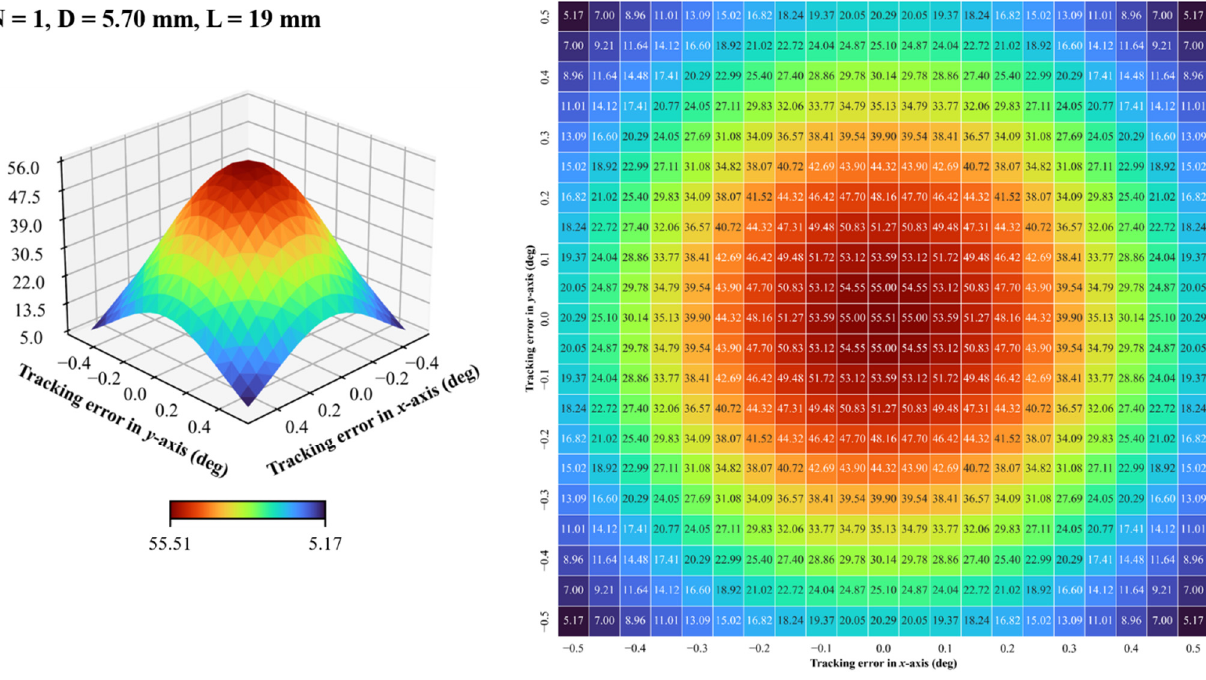
Figure 8. Total solar laser power in multimode regime as a function of the solar tracking error for the single 5.70 mm diameter, 19 mm length rod scheme.